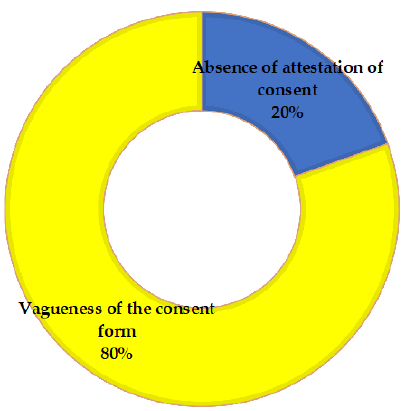
Figure 4. Cases of violations of consent admitted by the Court.